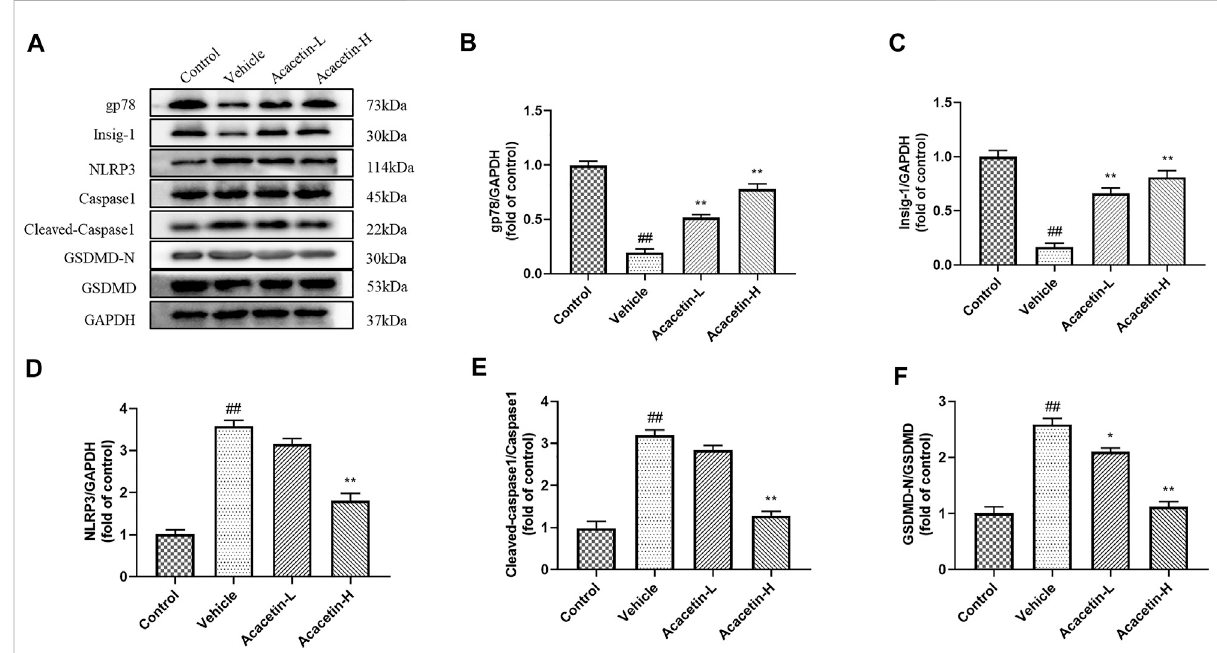
FIGURE 5 Effect of acacetin on gp78-mediated NLRP3 in fl ammasome in the cornea. (A) Representative western blots of gp78, Insig-1, NLRP3, Caspase1, cleaved Caspase1, GSDMD-N, and GSDMD. (B – F) Quantitative analysis of western blot results. Results are expressed as the mean ± SEM ( n = 3 per